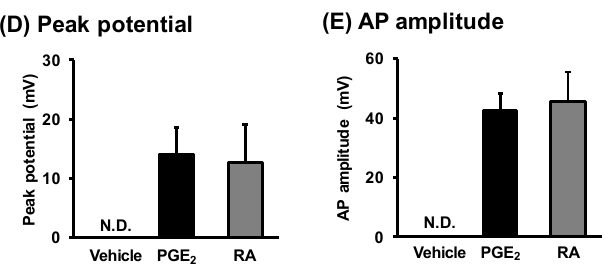
RAN.D. Vehicle PGE 2